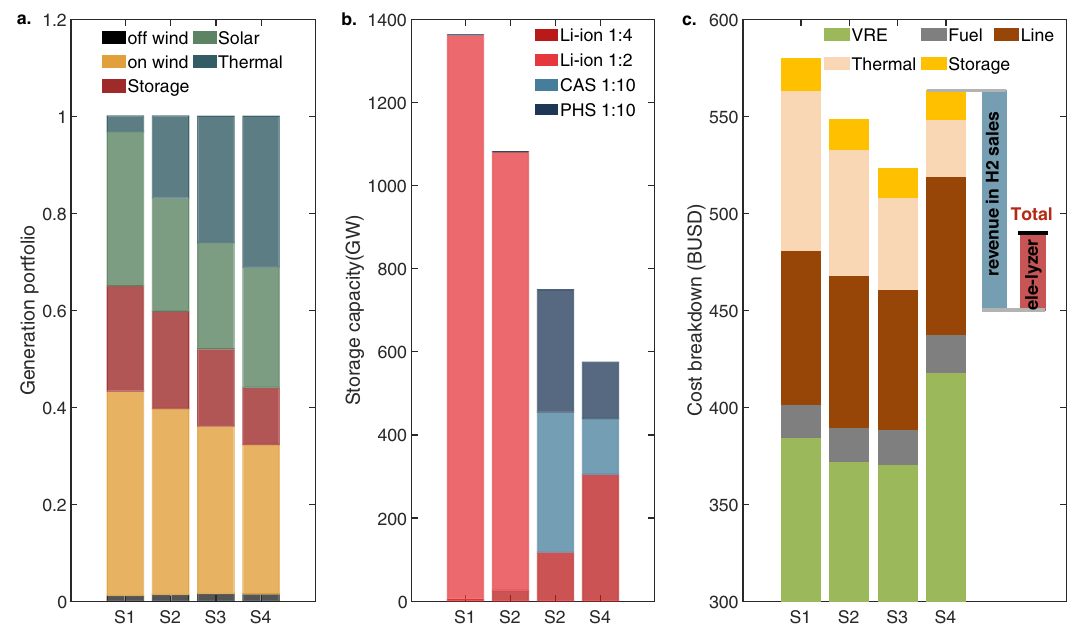
Fig. 5 | Generation portfolios, storage deployment and system costs under different offshore wind development scenarios. a Proportion of capacity incre- mentforallthenon-hydrorenewables,storagesystemsandthermalunitsinabove four scenarios. b Deployed storage capacity in the proposed scenarios. c System